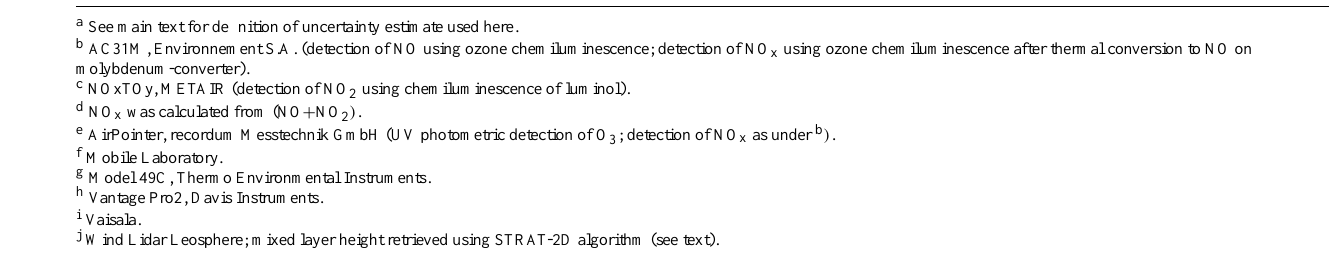
Table 2. Instrumentation for measurements of gas phase and meteorological parameters used for this analysis. Parameter(s) Site Instrument Time Uncertainty estimate resolution for comparisons a NO x Sub SW AC31M (NO) b , NOxTOy (NO 2 ) c,d 1min 20% Sub NE AirPointer e 1min Downtown AC31M (NO x ) b 5min MoLa f AirPointer e 1min O 3 Sub SW UV photometric O 3 analyzer g 1min 10% Sub NE AirPointer e 1min Downtown UV photometric O 3 analyzer g 5min MoLa AirPointer e 1min Temperature, RH, wind direction, wind speed Sub NE weather station h 1min only Sub NE: solar radiation MoLa weather station i 1min Mixed layer height Sub SW LIDAR j 1